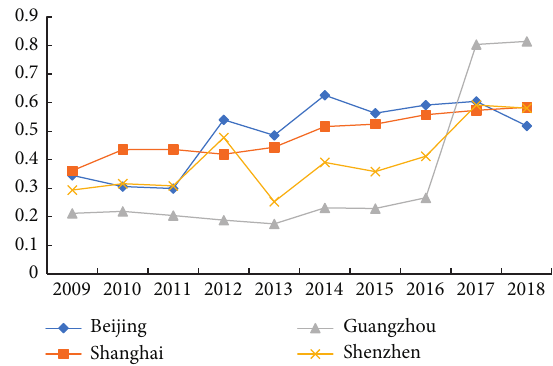
Figure 2: 2009–2018 Beijing, Shanghai, Shenzhen, and Guangzhou urban green development capabilities.